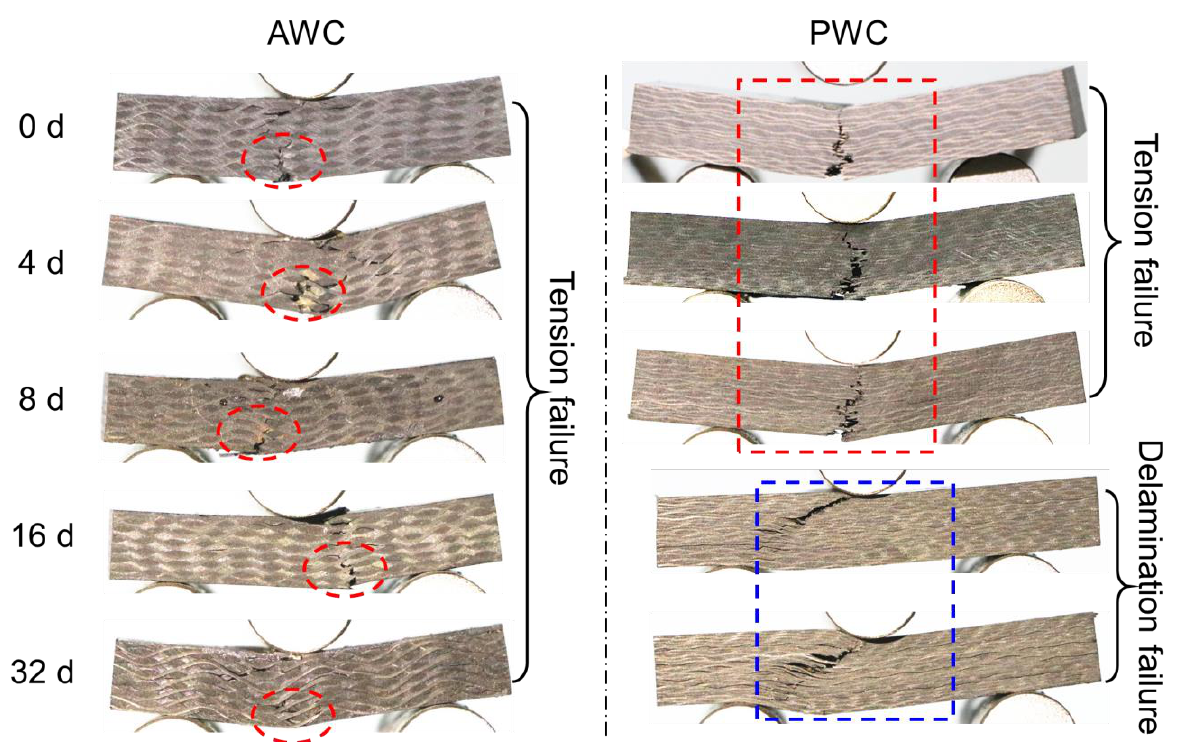
Figure 17. Failure morphologies of AWC and PWC with different ageing time. The failure modes of the AWC did not change much before and after ageing; the upper side of the specimen was under compression, leading to the initiation of interface